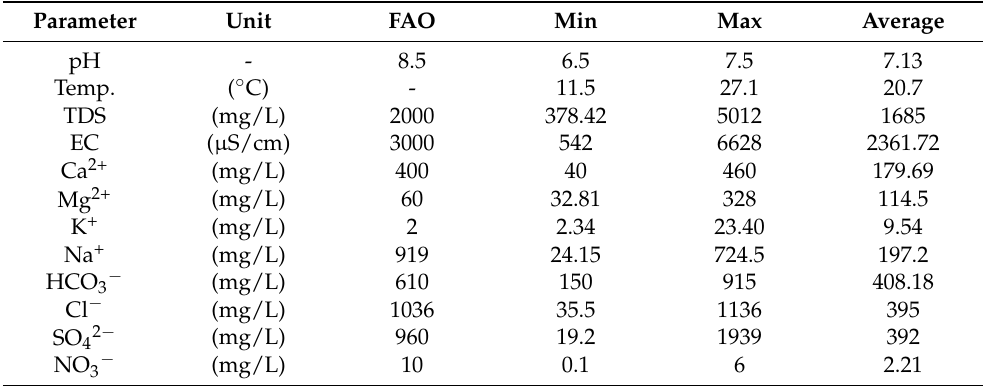
Table 3. Descriptive results of the groundwater samples with the standard limit for irrigation